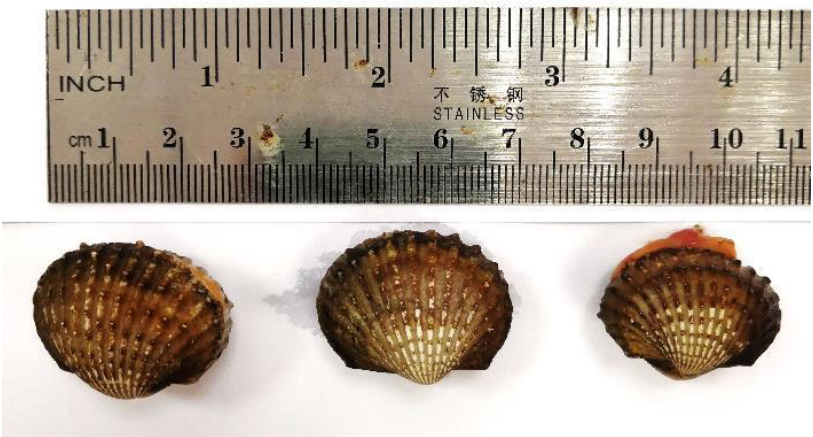
Figure 1. Tegillarca granosa samples used for nitrite exposure.